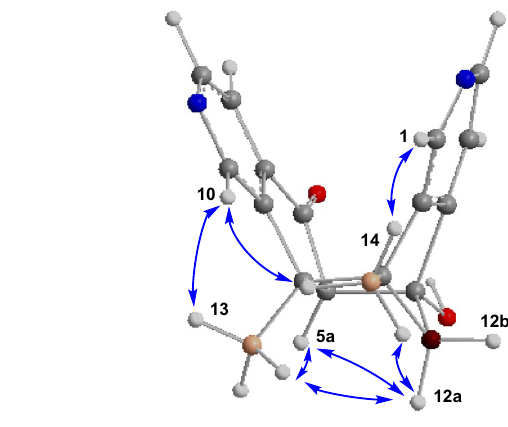
Figure 4. Characteristic COSY( ), HMBC ( 2,3 J H-C H C ) and NOE correlations ( ) of 6